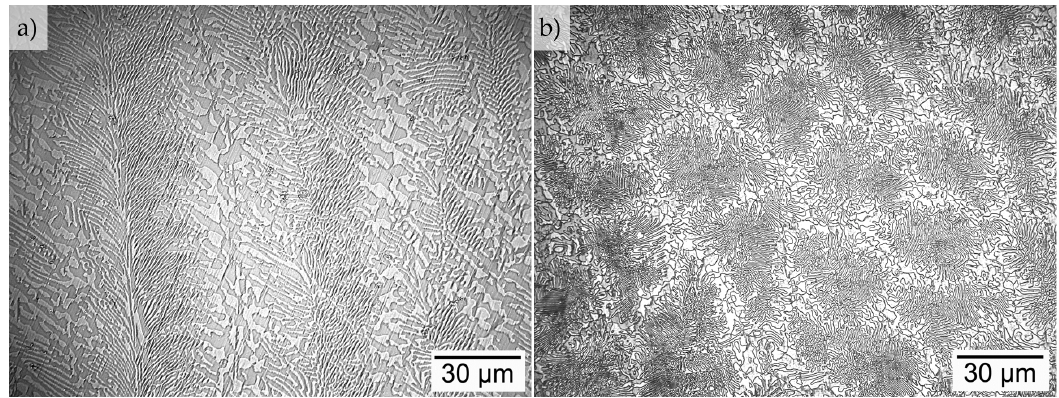
Figure 1. Optical micrograph of EC sample directionally solidified: ( a ) longitudinal section; and ( b ) cross-sectional view.